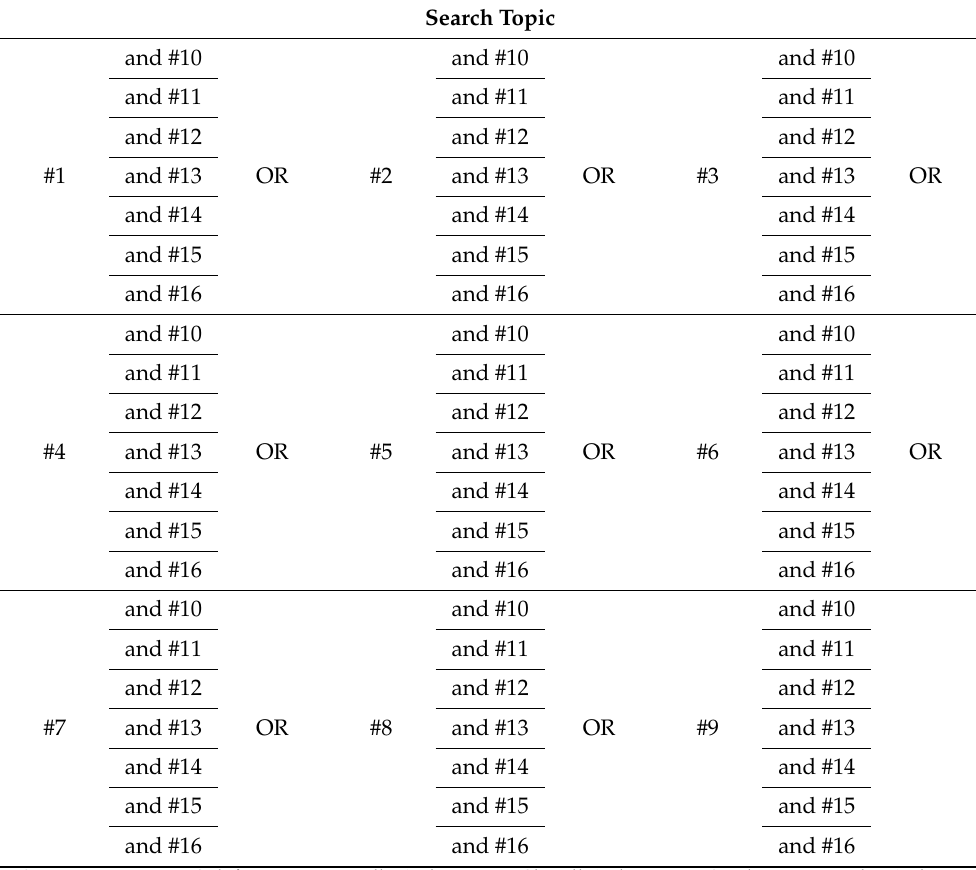
Table 1. The entire list used in the search and the combinations used in the research phase. Search